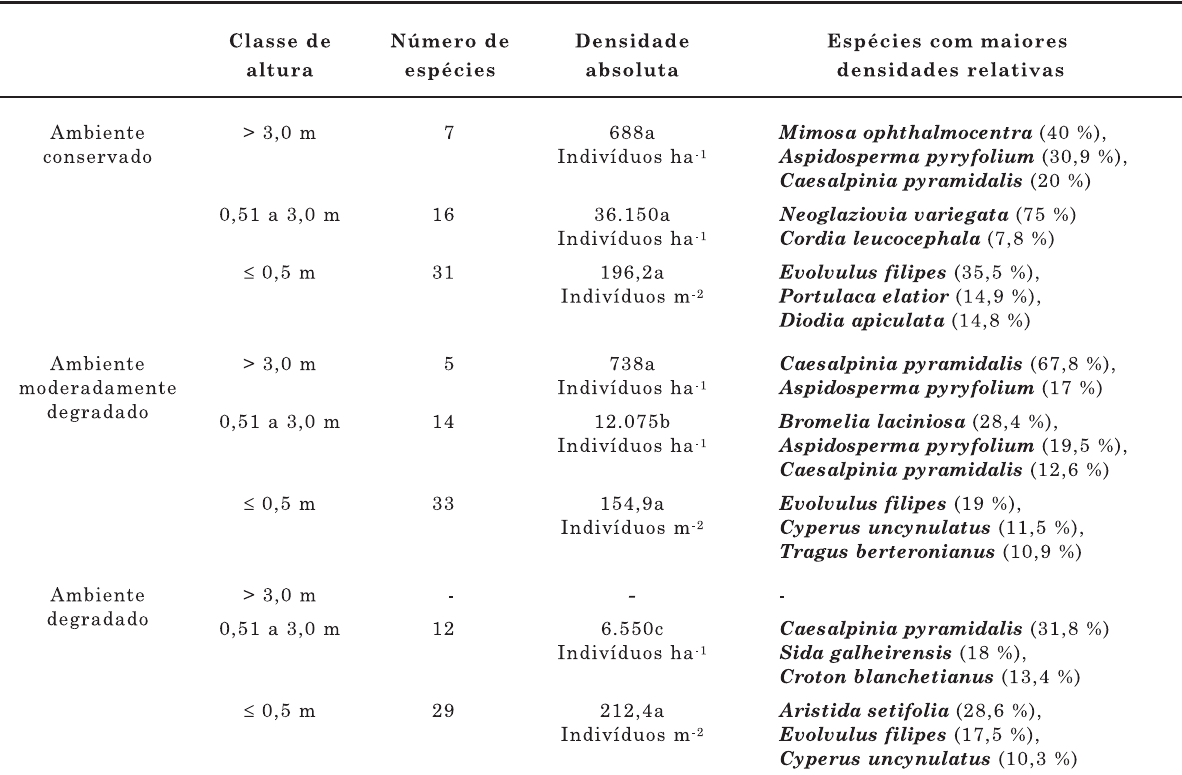
Quadro 1. Número de espécies amostradas, densidades absolutas e espécies com maiores valores